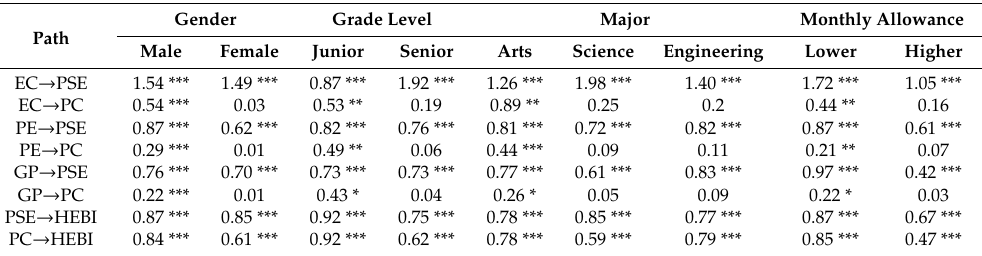
Table 8. Results of multi-group